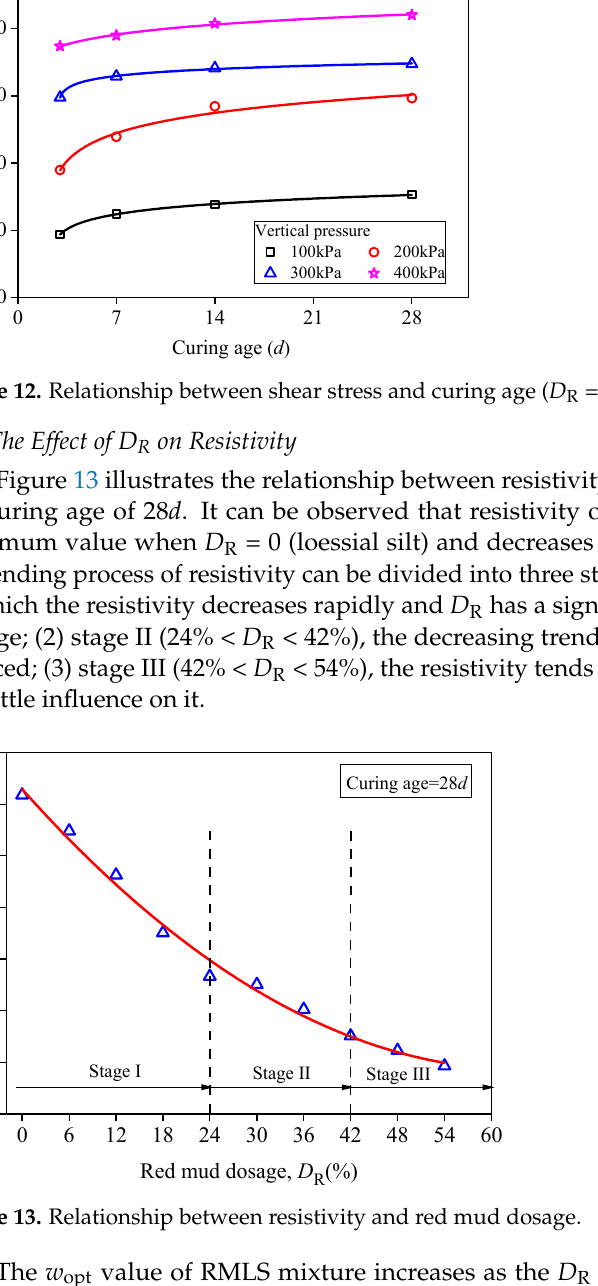
Figure 11. Relationship between shear stress and shear displacement.